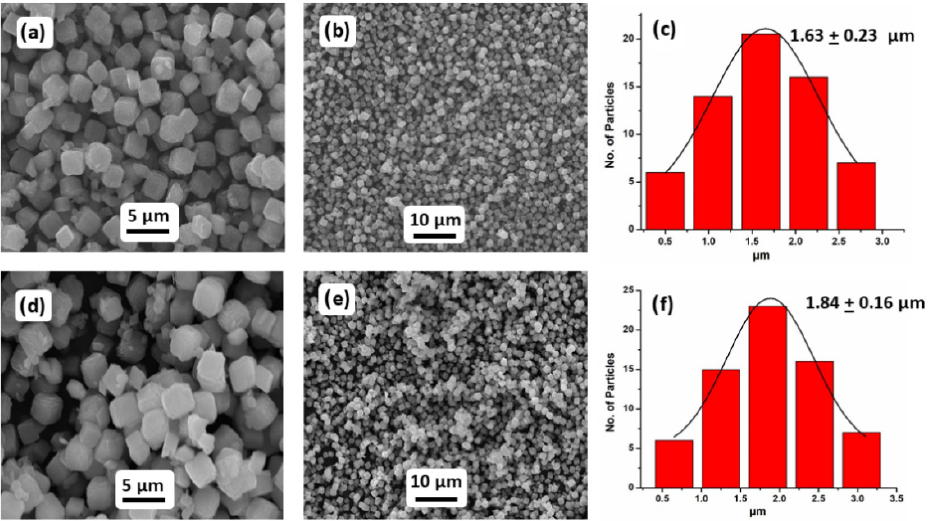
Figure 2. SEM analyses of prepared catalysts calcined at ( a , b ) 300 °C ((1%)Co x O y –MnCO 3 ) and ( d , e ) 500 °C ((1%)Co x O y –Mn 2 O 3 ). ( c ) Particle-size distribution of (1%)Co x O y –MnCO 3 and ( f ) particle-size distribution of (1%)Co x O y –Mn 2 O 3 .